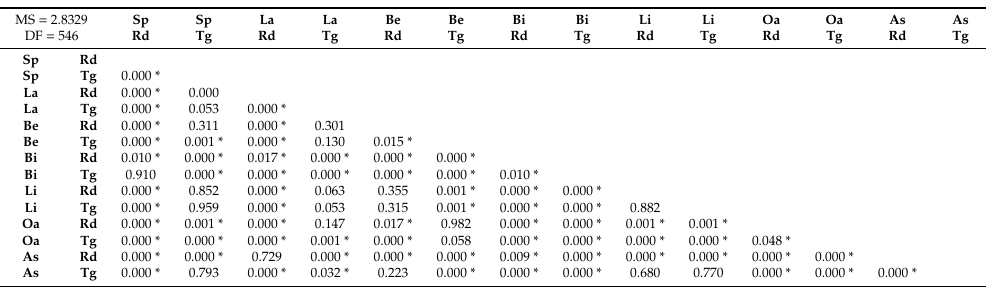
Table A2. Duncan’s Multiple Range Test for Toughness.